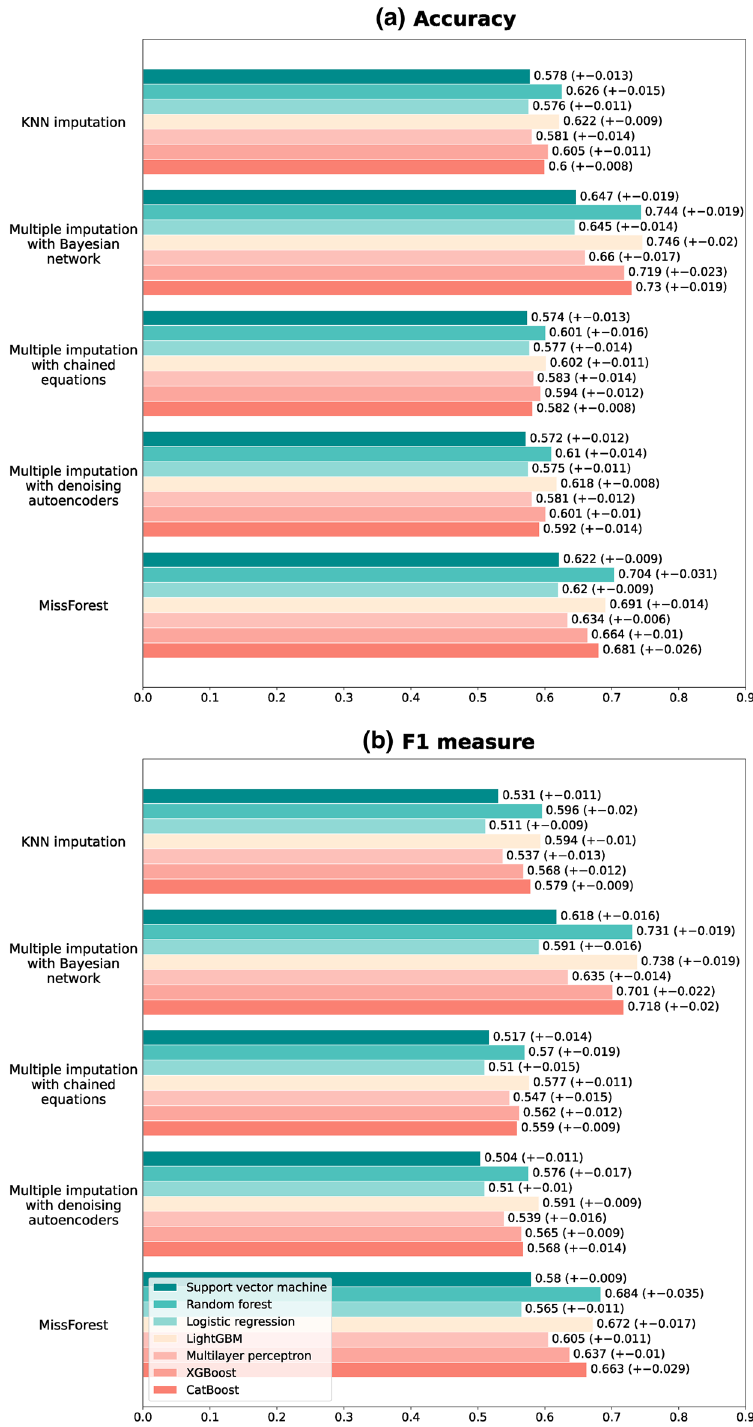
Figure 5. The accuracy and F1 measure of the classification models developed to predict the blood creatinine level. The 95% confidence interval for the criterion is indicated in